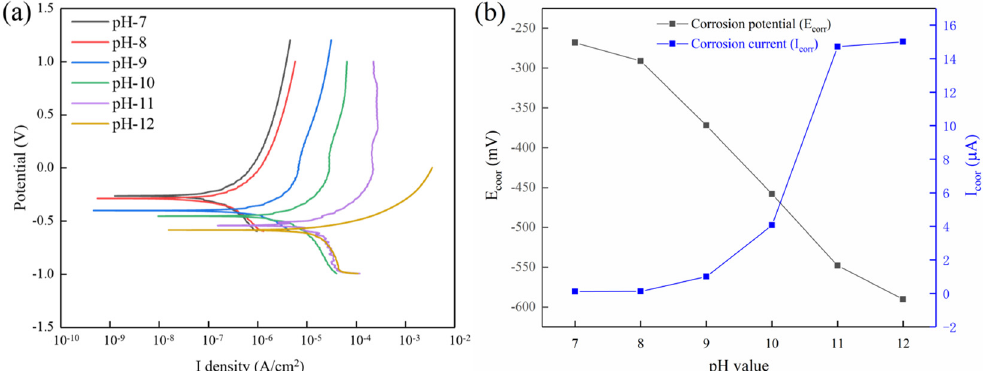
Figure 12. ( a ) Dynamic potential polarization curves at different pH solutions. ( b ) The corrosion potential E corr and the corrosion current density I corr at different pH solutions.